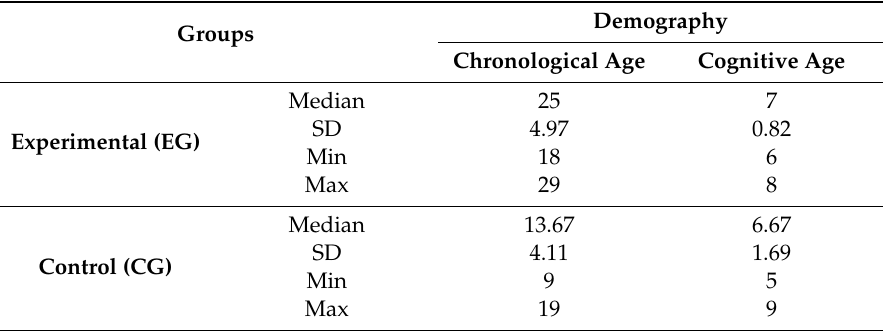
Table 2. Participants in the